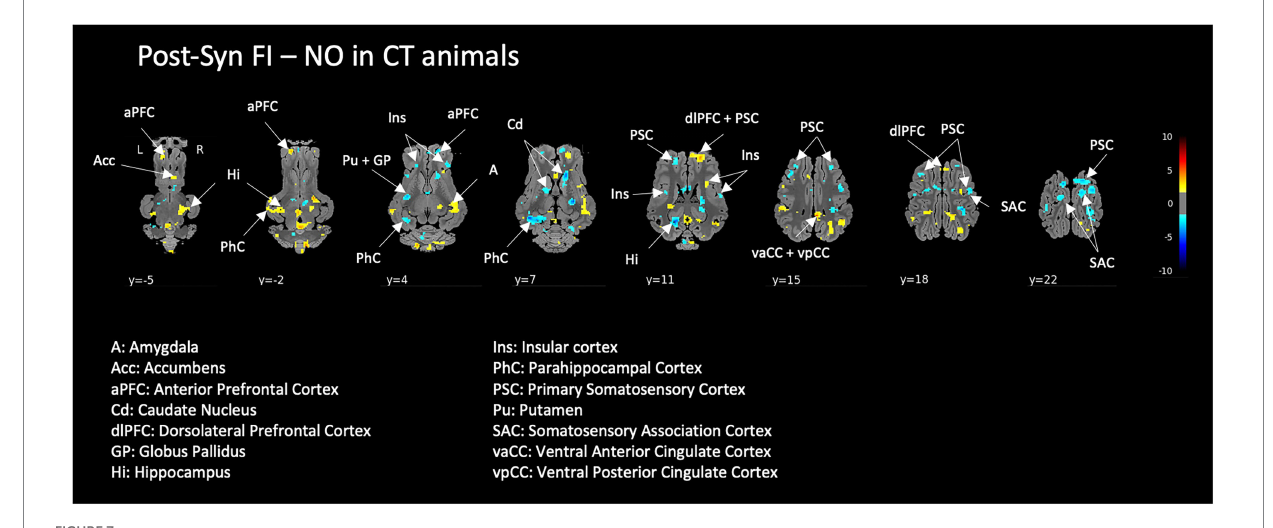
FIGURE 7 Effect of the exposure to the functional food ingredient (FI compared to non-odorized air, NO) on the brain responses to a pharmacological acute stress in naive control (CT) animals. Horizontal maps of brain BOLD responses are represented at different dorsal-ventral levels ( y ) related to the posterior commissure (in mm). Value of p threshold = 0.05, k > 20 (number of voxels per